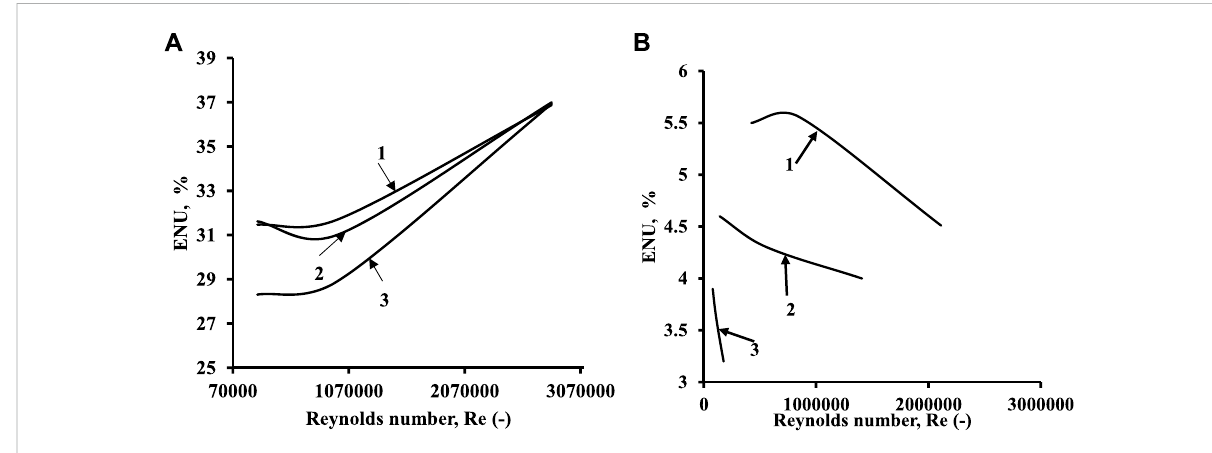
FIGURE 13 Variation of ENU with the Reynolds number for different pressures. (A) Without a distributor. (B) With distributor. Index: 1) p = 10 bar; 2) p = 40 bar; and 3) p = 70